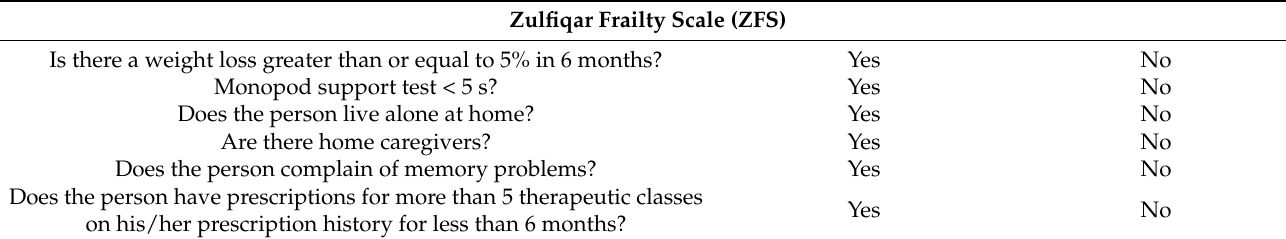
Table 2. Criteria of the Zulfiqar Frailty Scale